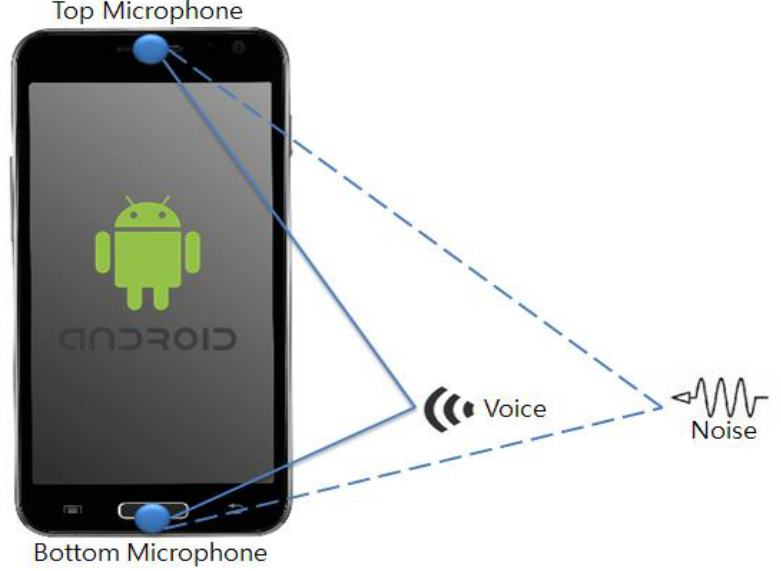
Figure 1. Measuring principle using microphone sensors .